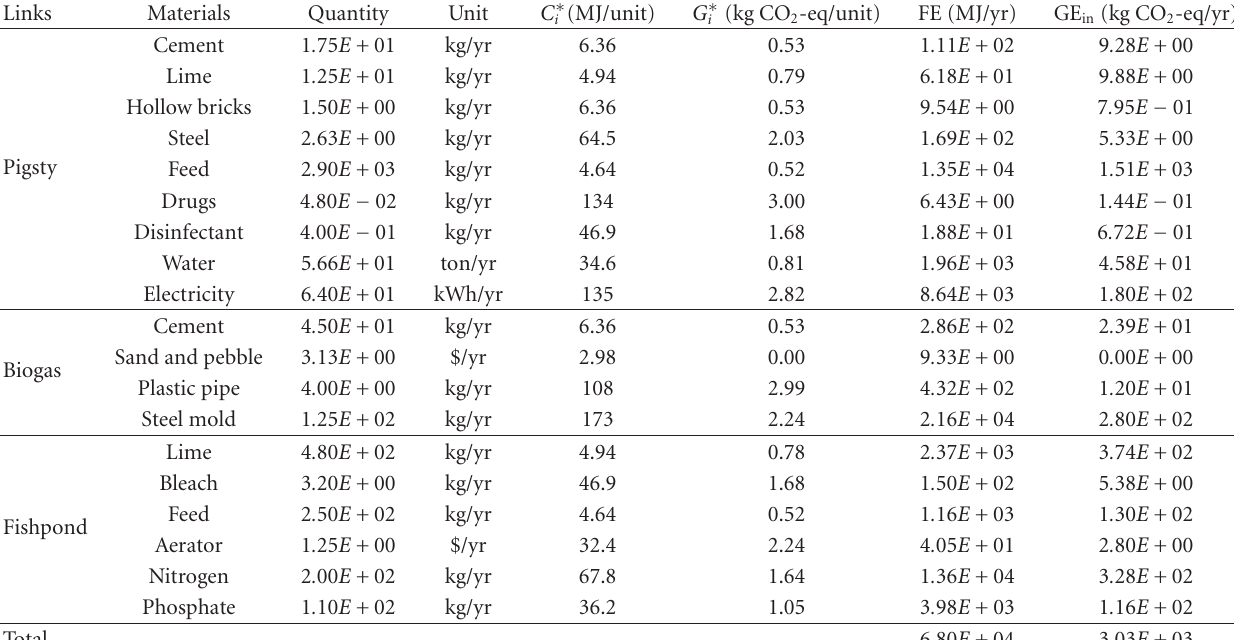
Table 2: FE cost and GE in emissions of the “pig-biogas-fish” system.